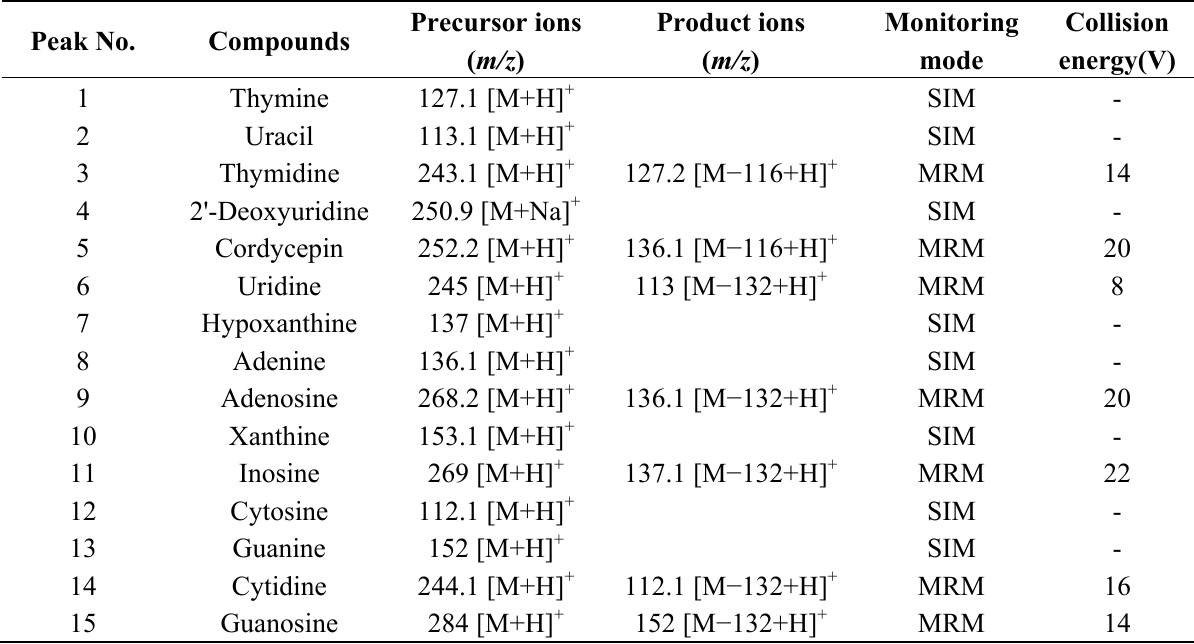
Table 1. ESI-MS and ESI-MS/MS ions of nucleosides and nucleobases in Cordyceps .